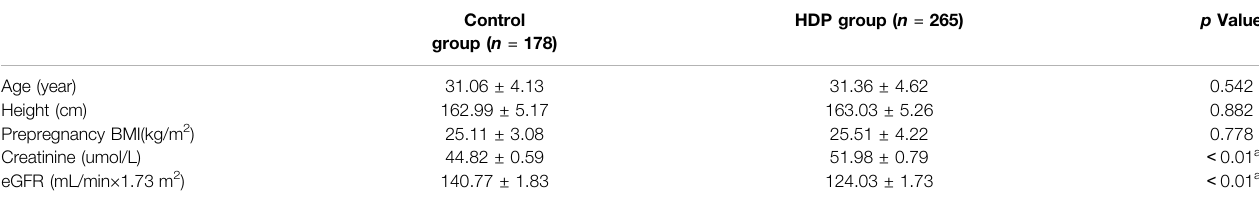
TABLE 1 | Demographic characteristics of the two groups.